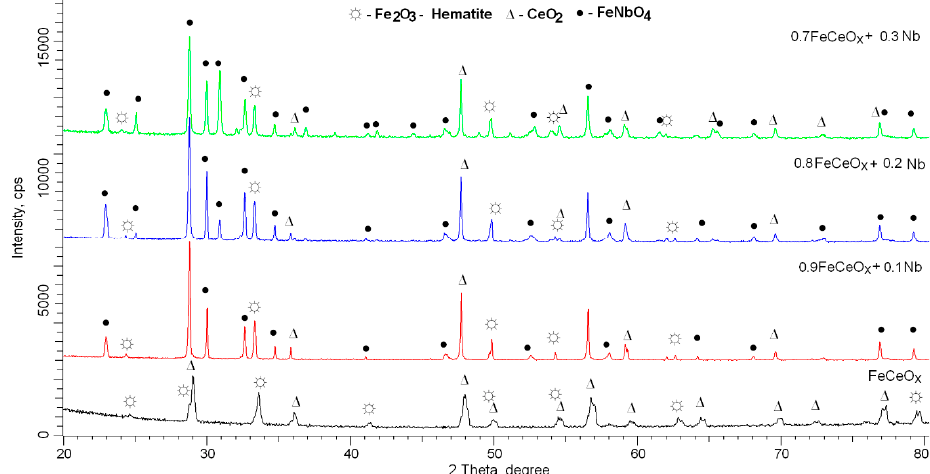
Figure 4. X-ray diffraction pattern of the studied samples FeCeO x nanoparticles doped Nb 2 O 5 with different concentration.